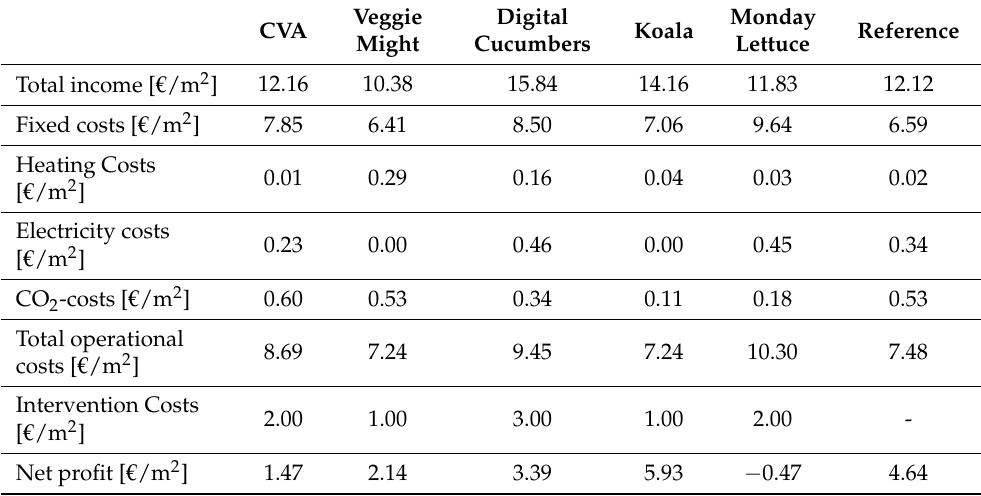
Table 2. Net profit of different teams in the second experiment consisting of crop income minus costs (fixed costs, heating costs, electricity costs, CO 2 costs, and intervention costs).